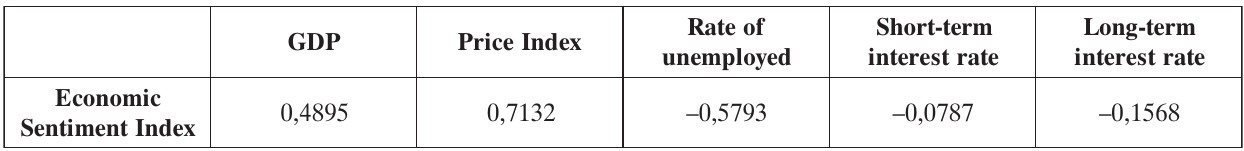
Fig 4. Correlation coefficients: Ifo vs Indicators, 2002–2005 Table 3. Correlation coefficients in Latvia (2003–2005)